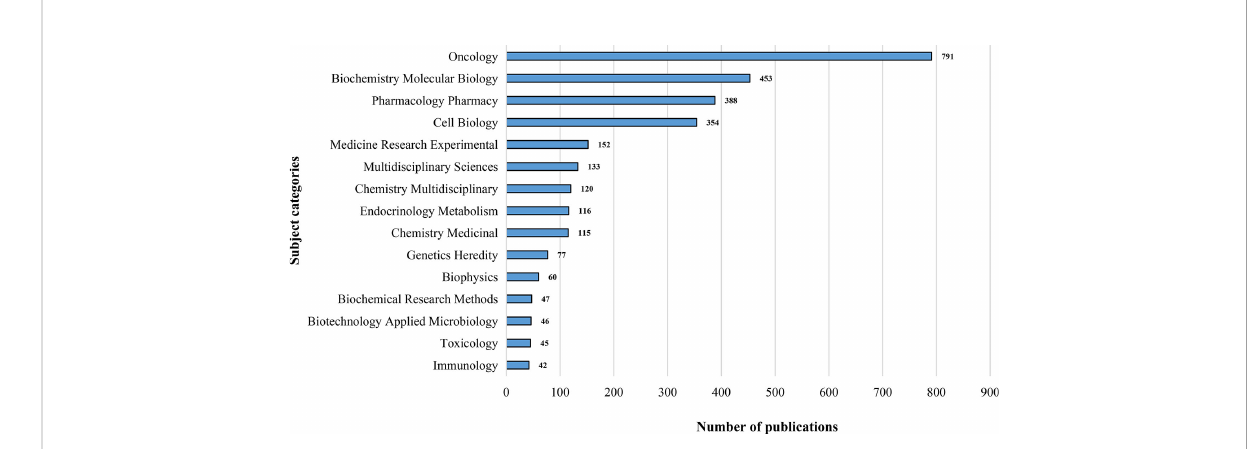
FIGURE 4 The top 15 subject categories related to metabolic signaling pathways of tumor drug